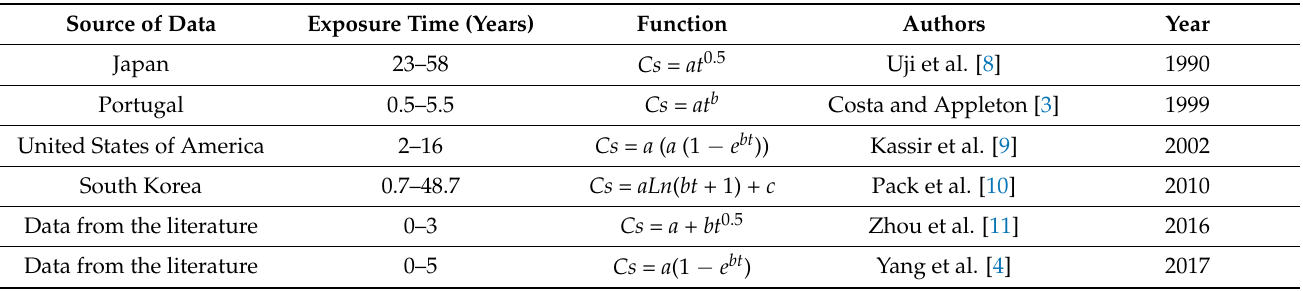
Table 1. Models from the literature used to represent the behaviour of surface chloride concentration in concrete in the marine atmosphere zone.